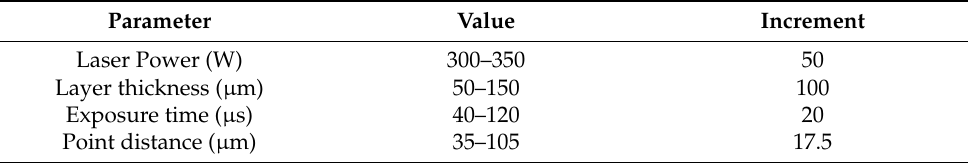
Table 2. The process parameters of the single-track experiments.